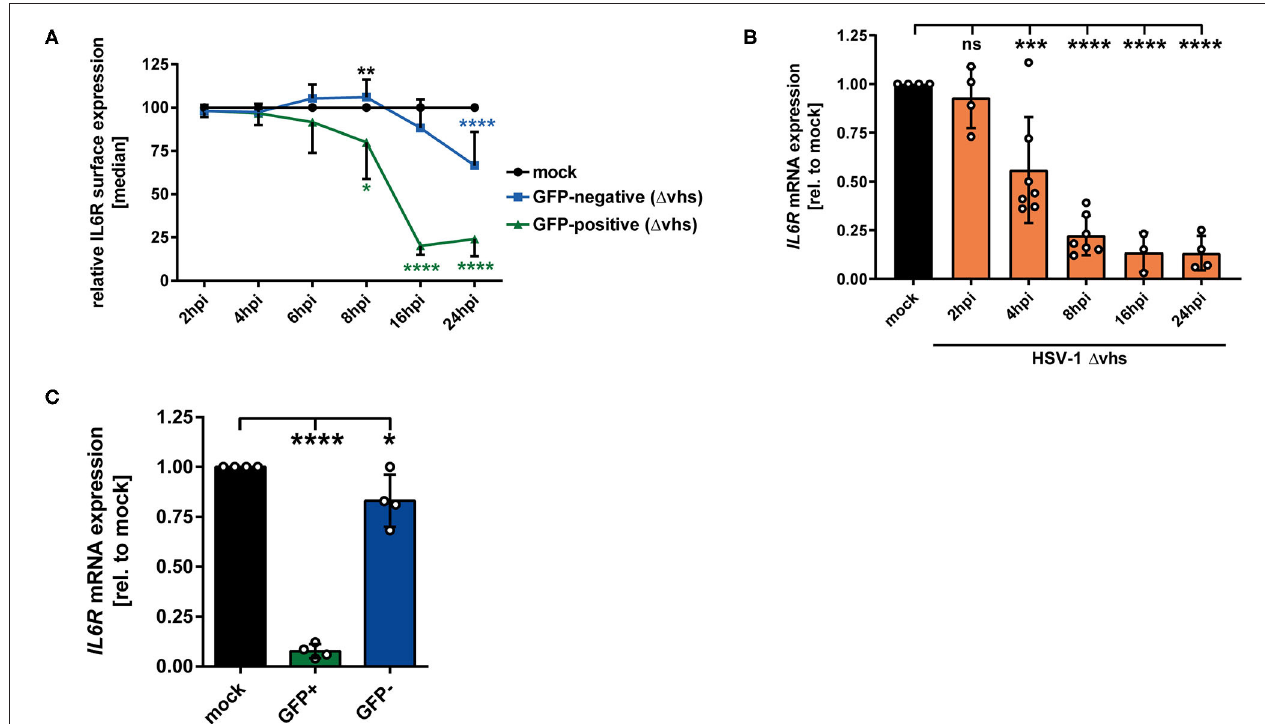
FIGURE 6 | HSV-1 viral protein vhs is partially involved in IL6R regulation in infected mDCs as well as in uninfected bystander mDCs. (A) Mature DCs were mock- or HSV-1 1 vhs-infected (MOI of 0.6) and harvested at indicated time points post infection. IL6R surface expression was analyzed on mock (set to 100%, black line), GFP-positive (green line) and GFP-negative (blue line) HSV-1 1 vhs-infected mDCs by flow cytometry. Distinction between infected and uninfected mDCs is based on the GFP signal and the used gates in data evaluation software FCS Express 5, which are specific for either the GFP-positive or GFP-negative population. This experiment was performed three times with cells derived from different healthy donors. Green asterisks indicate statistical analyses of GFP-positive to mock-treated mDCs, blue asterisks the statistical analyses of GFP-negative to mock-treated mDCs and, black asterisks the statistics of GFP-negative to GFP-positive conditions. (B) Mature DCs were mock treated (black bar), or HSV-1 1 vhs-infected (MOI of 2, orange bars) and harvested at indicated time points post infection (2–24 hpi). RNA was isolated and qPCR was performed using transcribed cDNA. Relative IL6R mRNA expression levels are normalized to S14 and are shown relative to the respective mock condition. This experiment was performed three to seven times with cells derived from different healthy donors. (C) Mature DCs were mock- or HSV-1 1 vhs-infected (MOI of 0.6) and harvested 16 hpi. Subsequently, cells were sorted based on their GFP expression into GFP-positive and GFP-negative mDCs fraction. RNA was isolated and transcribed cDNA used for subsequent qPCR experiments. Relative IL6R mRNA expression is normalized to S14 and transcript levels are shown relative to the respective mock condition. Data points are based on the analyses of cells from four different healthy donors. Error bars indicate SD.